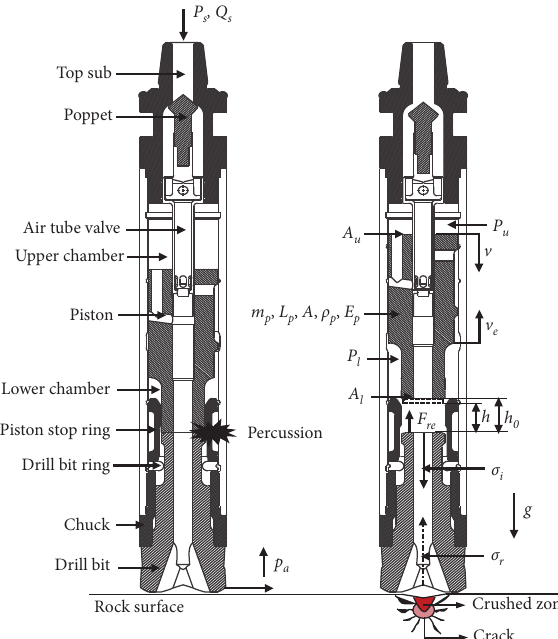
Figure 2: Schematic of the rock fracture mechanism by percussive drilling (modified from [1,